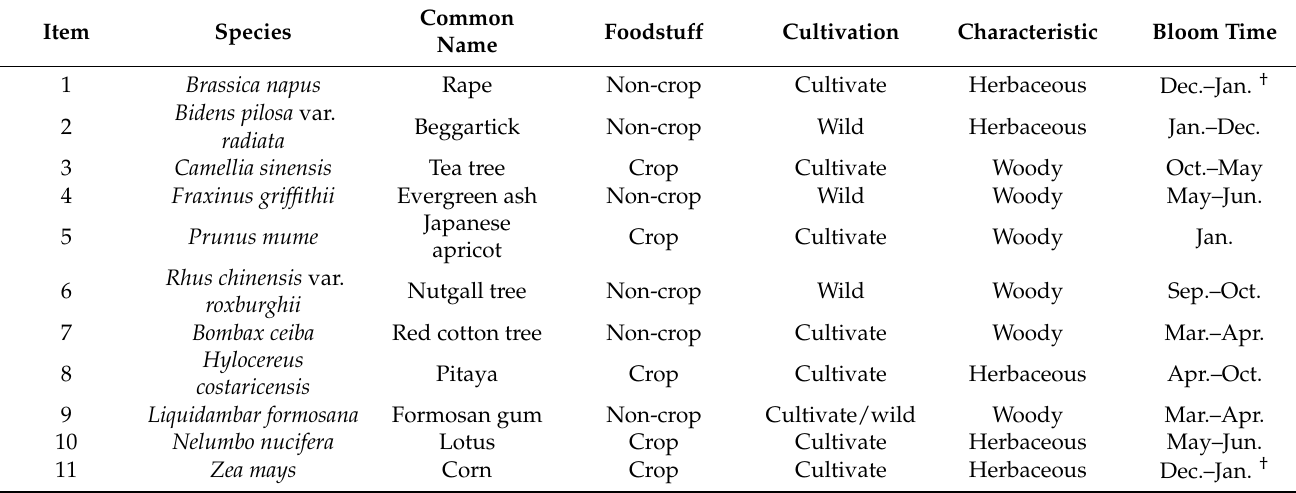
Figure 1. Eleven monofloral bee pollen samples. (1) Brassica napus , (2) Bidens pilosa var. radiata , (3) Camellia sinensis , (4) Fraxinus griffithii , (5) Prunus mume , (6) Rhus chinensis var. roxburghii , (7) Bombax ceiba , (8) Hylocereus costaricensis , (9) Liquidambar formosana , (10) Nelumbo nucifera , and (11) Zea mays . Table 1. Common botanical origins for bee pollen production in